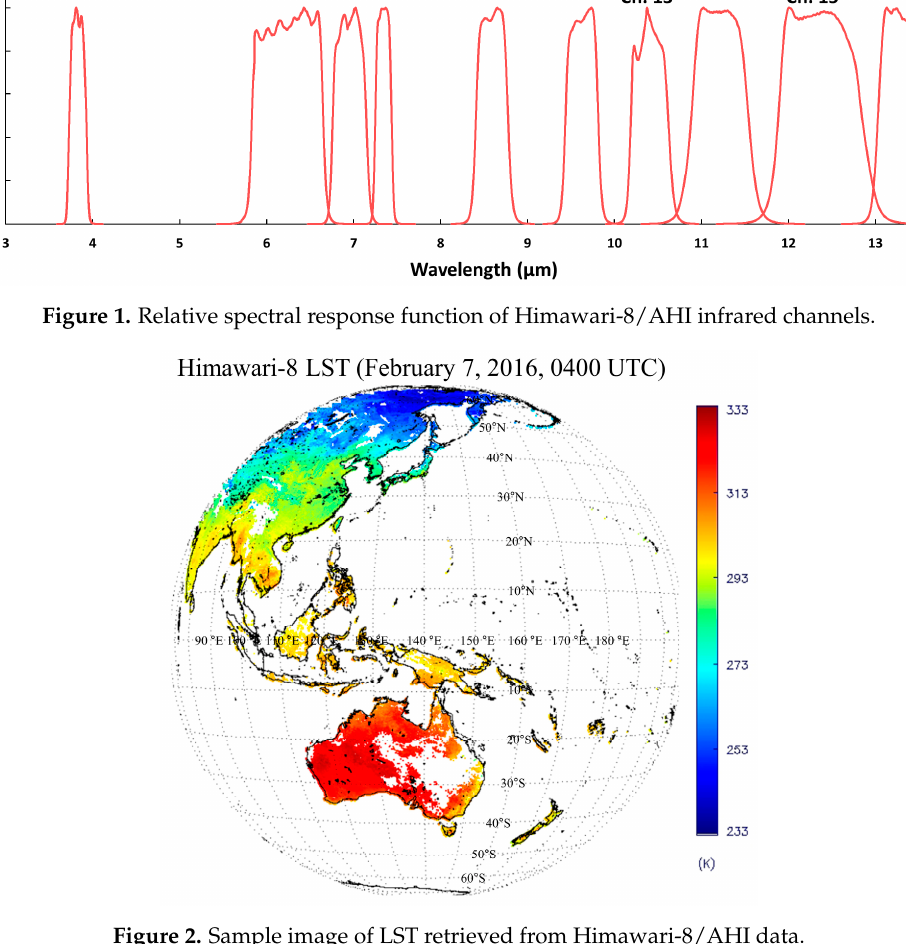
Figure 2. Sample image of LST retrieved from Himawari-8/AHI data.